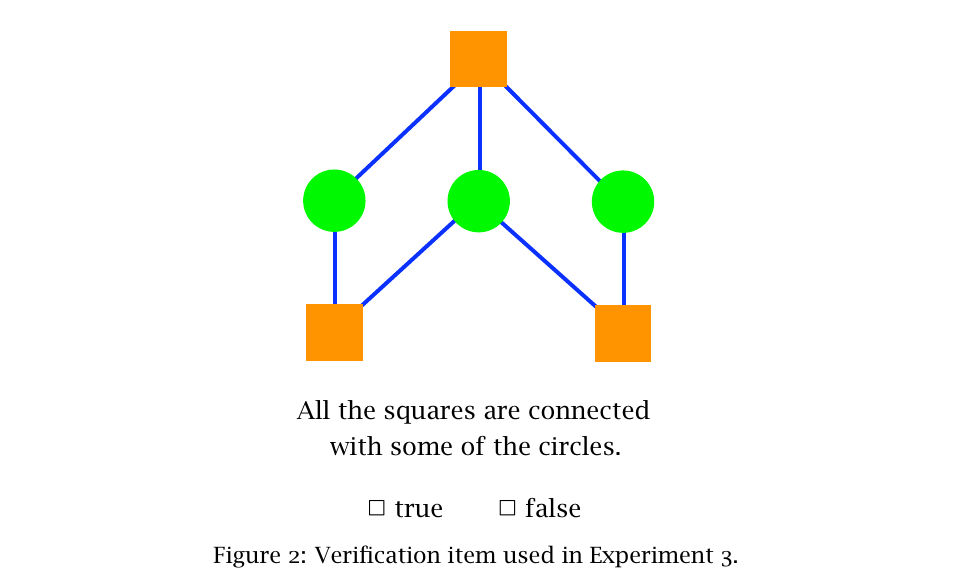
Figure 2 : Verification item used in Experiment 3